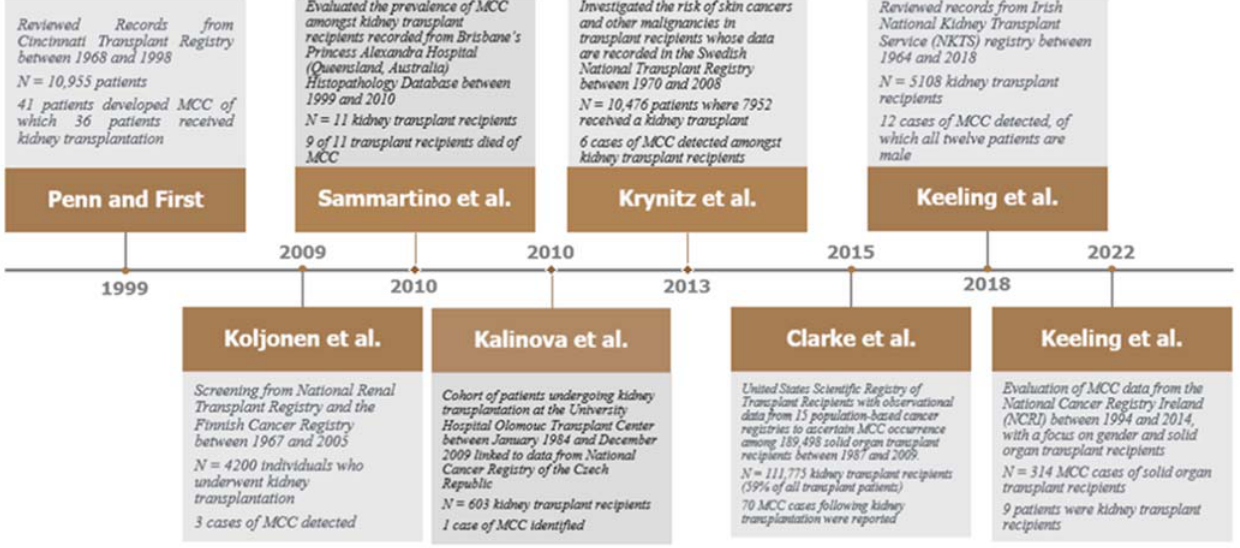
Figure 2. Timeline of epidemiological cohort studies reporting MCC characteristics in kidney transplant recipients. MCC: Merkel Cell Carcinoma. plant recipients. MCC: Merkel Cell